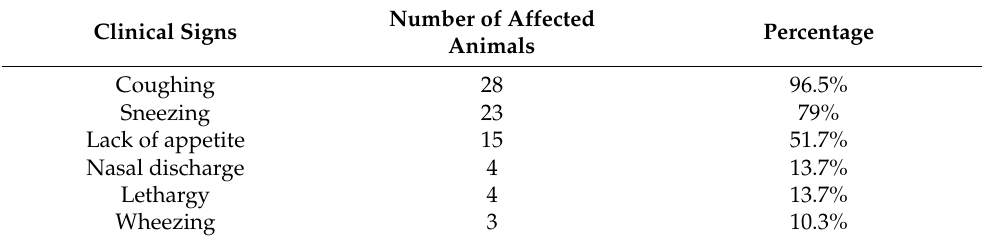
Table 2. Clinical signs in wild felines resulting from SARS-CoV-2 infection [26,28,40,41]. Clinical